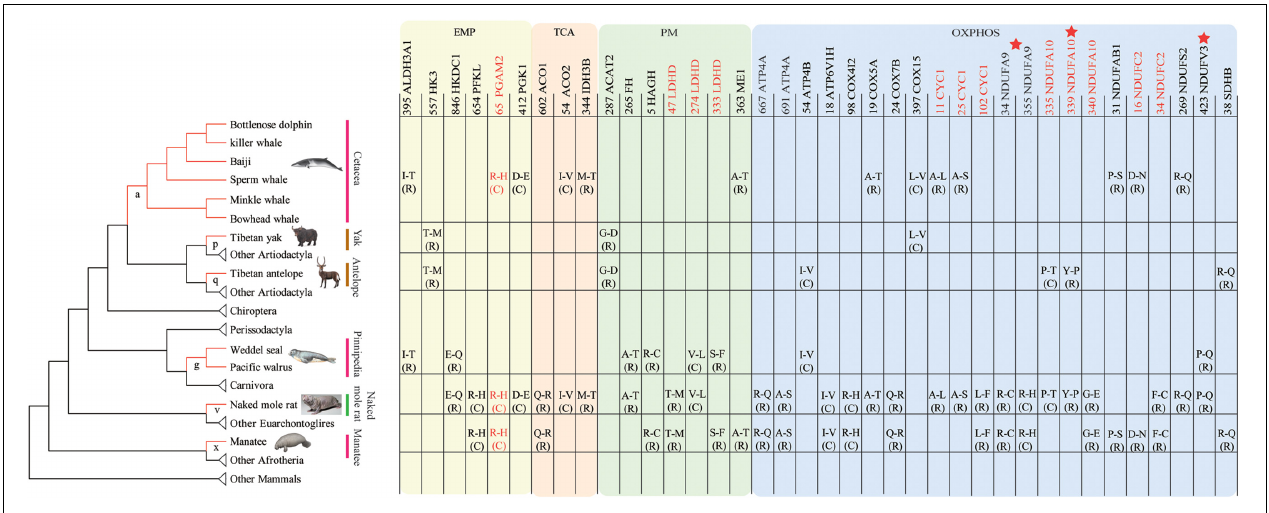
FIGURE 4 | Parallel/convergent amino acid substitutions specifically occurred along hypoxia-tolerant species. Red sites represent parallel non-synonymous amino acid substitutions occurred along more than 3 hypoxia-tolerant lineages; Stars represent PSGs. Branch a represented the last common ancestor (LCA) of cetaceans, g of the LCA of pinnipeds, x of West Indian manatee, p of the Tibetan yak, q of the Tibetan antelope, and v of the naked mole rat,